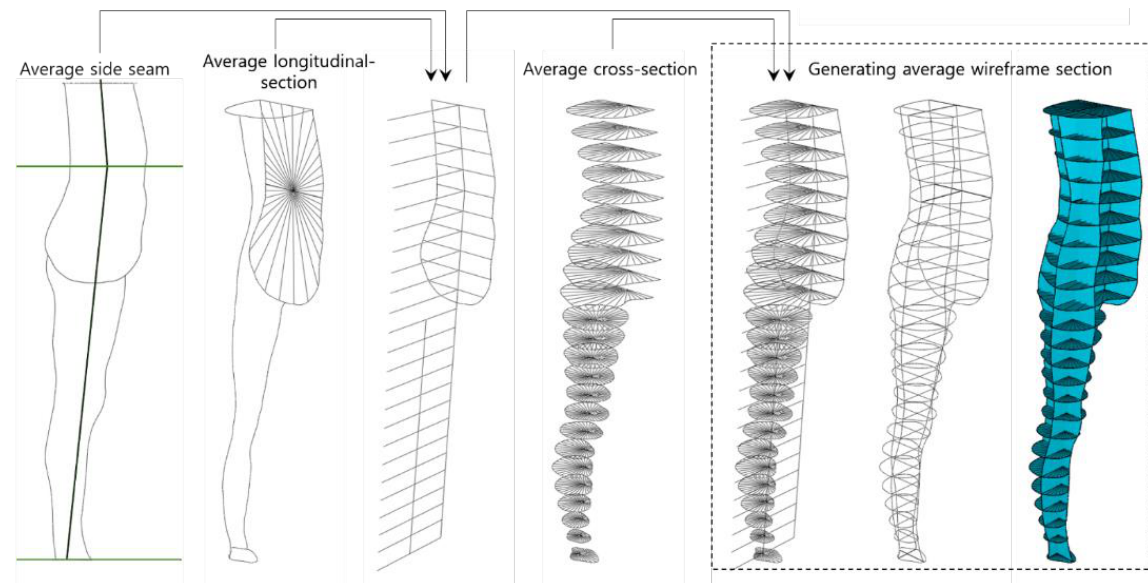
Figure 6. Process of average wireframe generation.